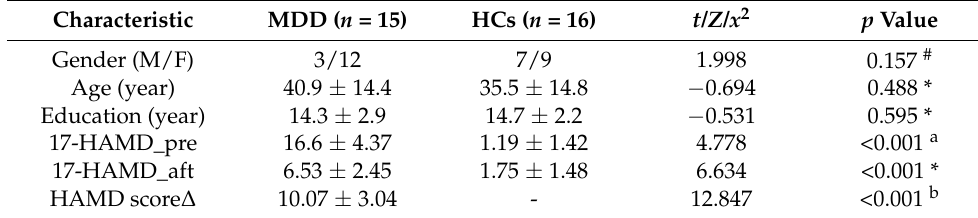
Table 1. Characteristics of MDD group and